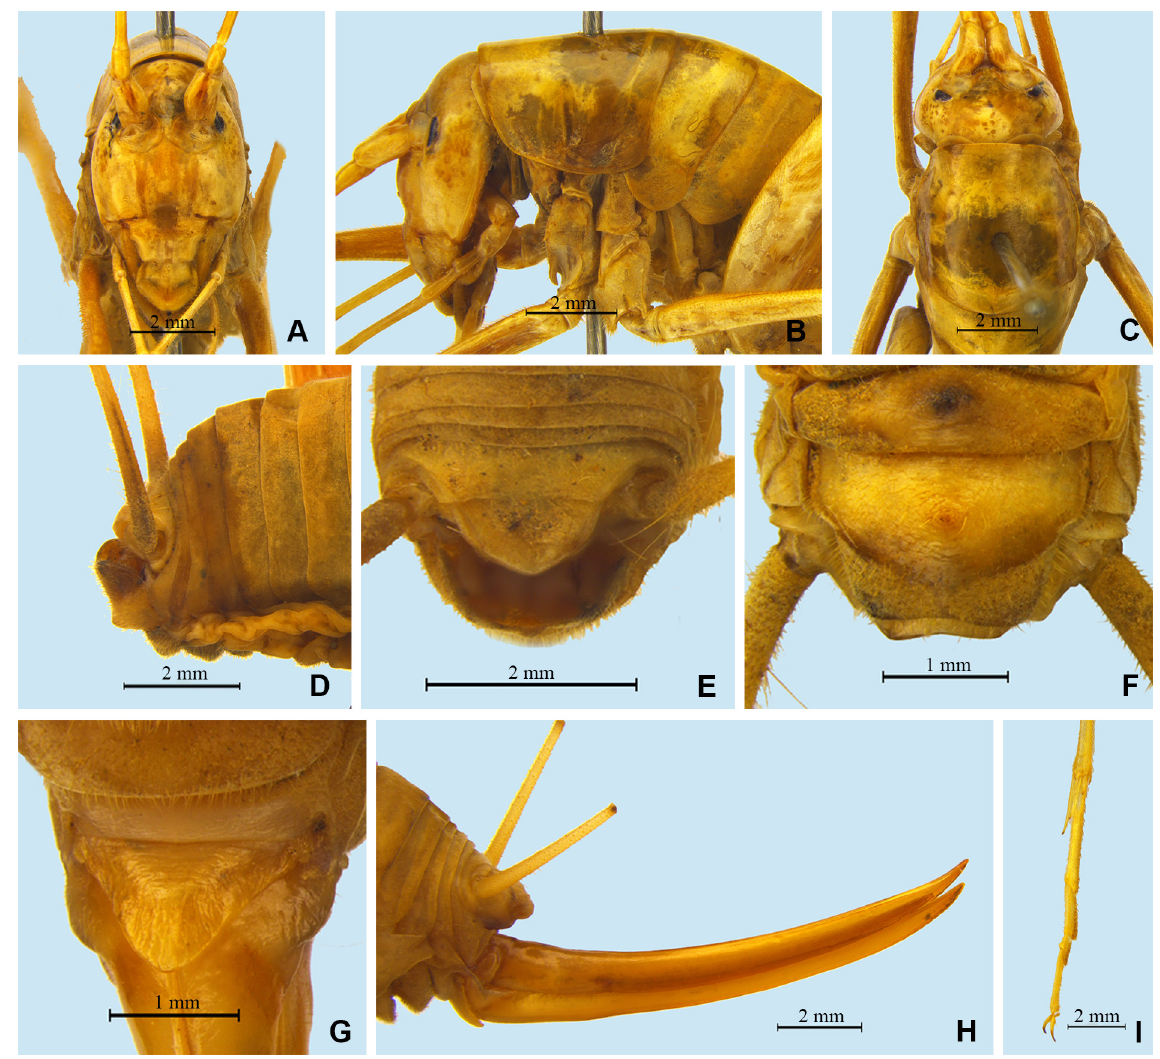
Fig. 3. Tachycines ( Gymnaeta ) sparsispinus sp. nov. A–F, I . Paratype, ♂ (HBU). A–C . Head